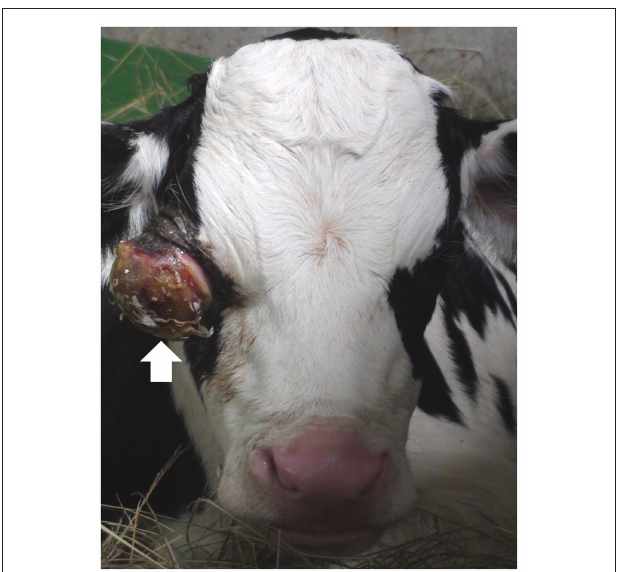
eyeball. A 2-cm-thick echogenic parenchymal lesion (asterisk) is evident together with a floating membrane-like structure (arrow) in the anterior side of the right